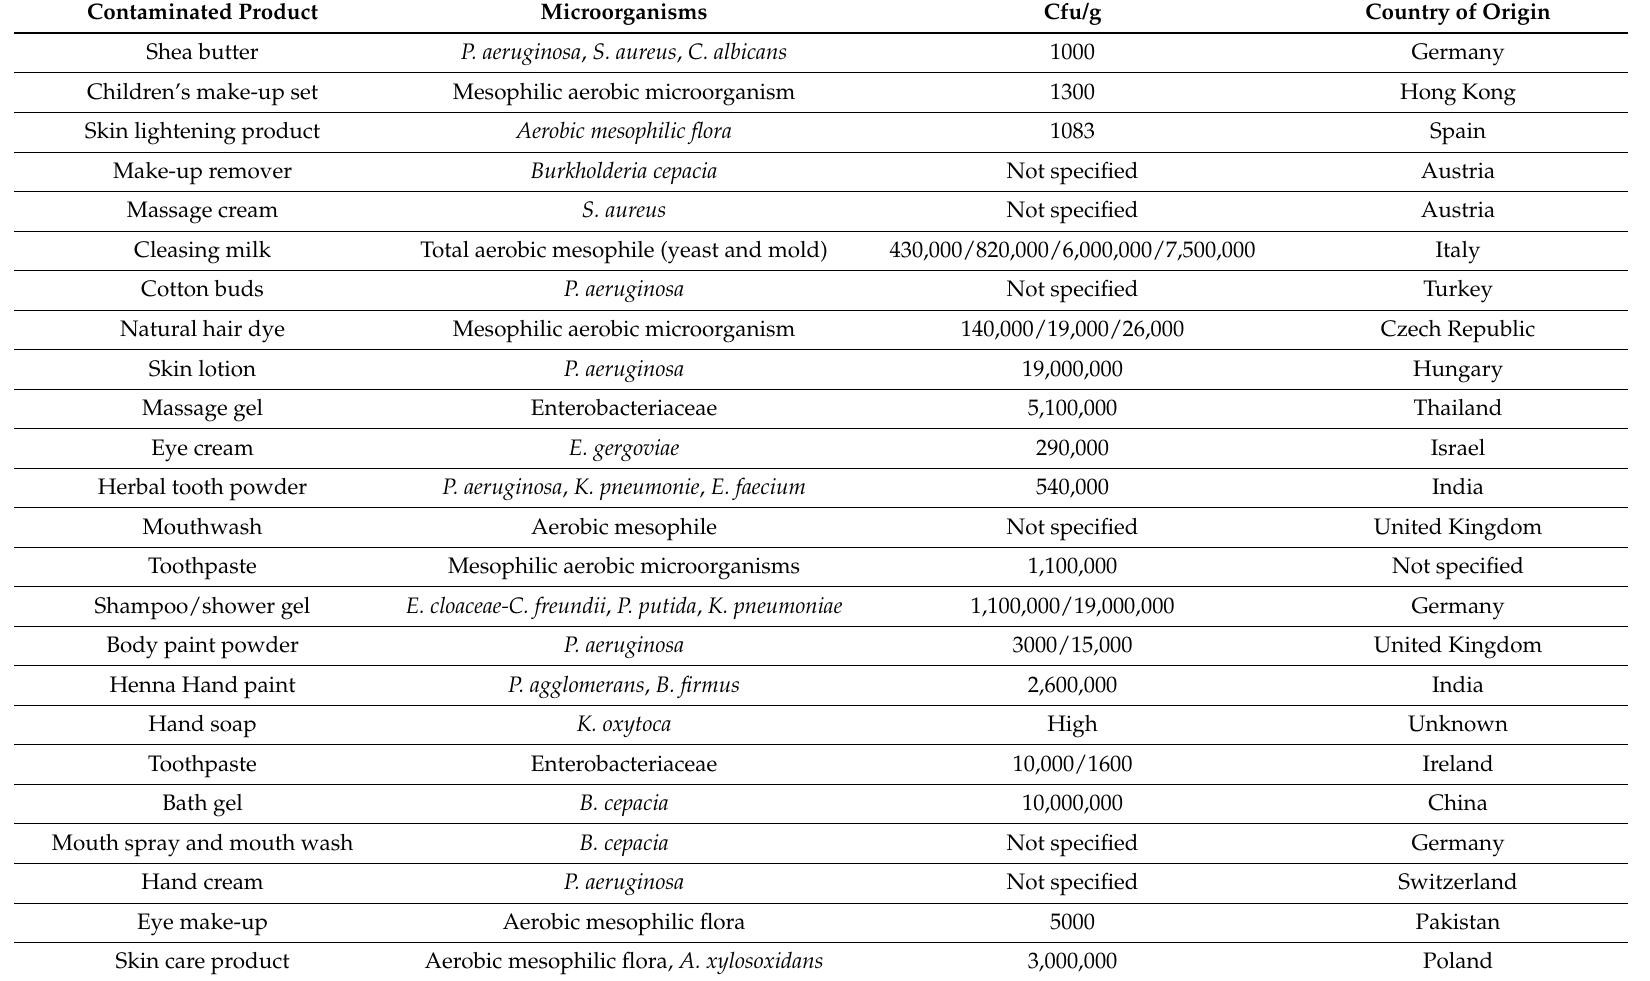
Table 1. Microbiologically contaminated